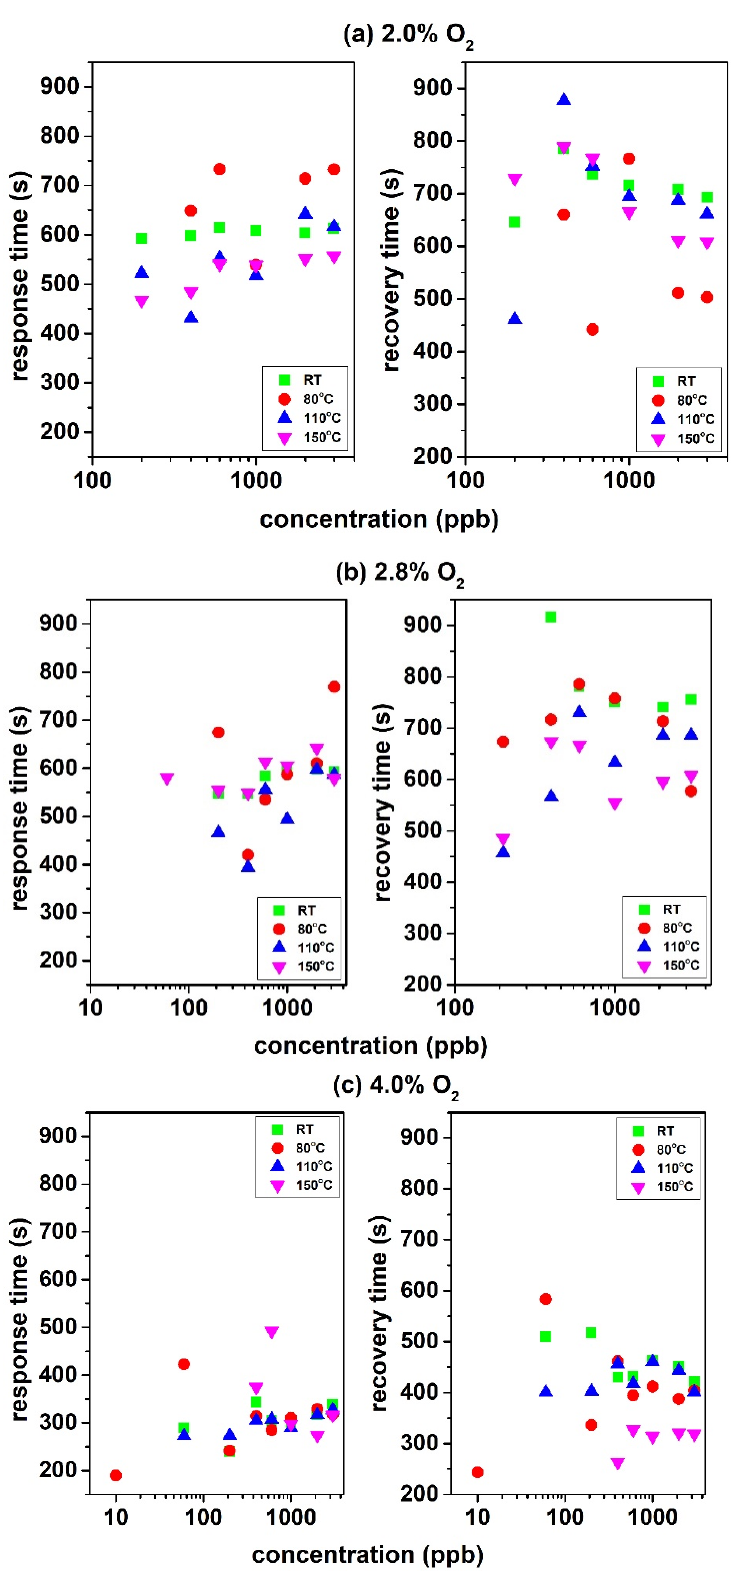
Figure 8. Response and recovery times at different operating temperatures of rf-sputtered NiO:Al with ( a ) 2.0%, ( b ) 2.8%, and ( c ) 4.0% O 2 in plasma as a function of ozone concentrations.